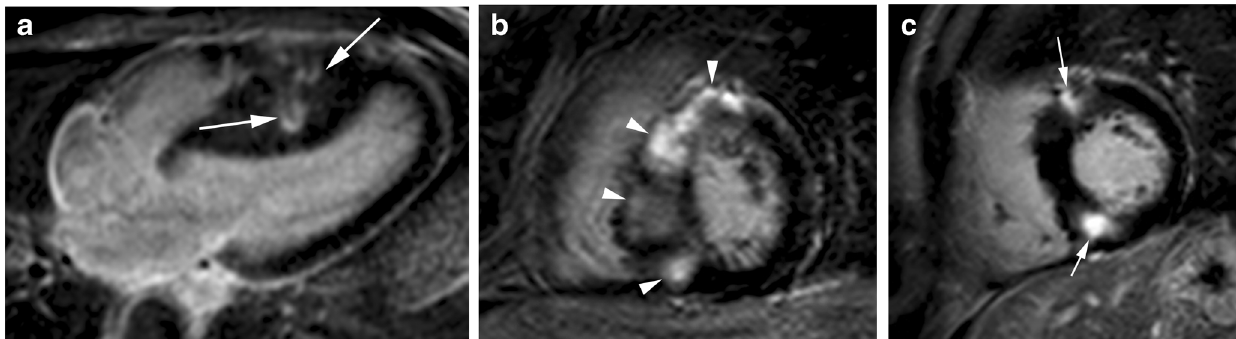
Fig. 7 Most common distribution of LGE in classic HCM phenotype. a , 16-year-old man with septal HCM and recurrent ventricular tachycardia. Four-chamber LGE image shows isolated patchy mid-wall septal en- hancement (arrows); b , 65-year-old man with palpitations and syncope and diffuse HCM. Short-axis LGE image demonstrates diffuse patchy